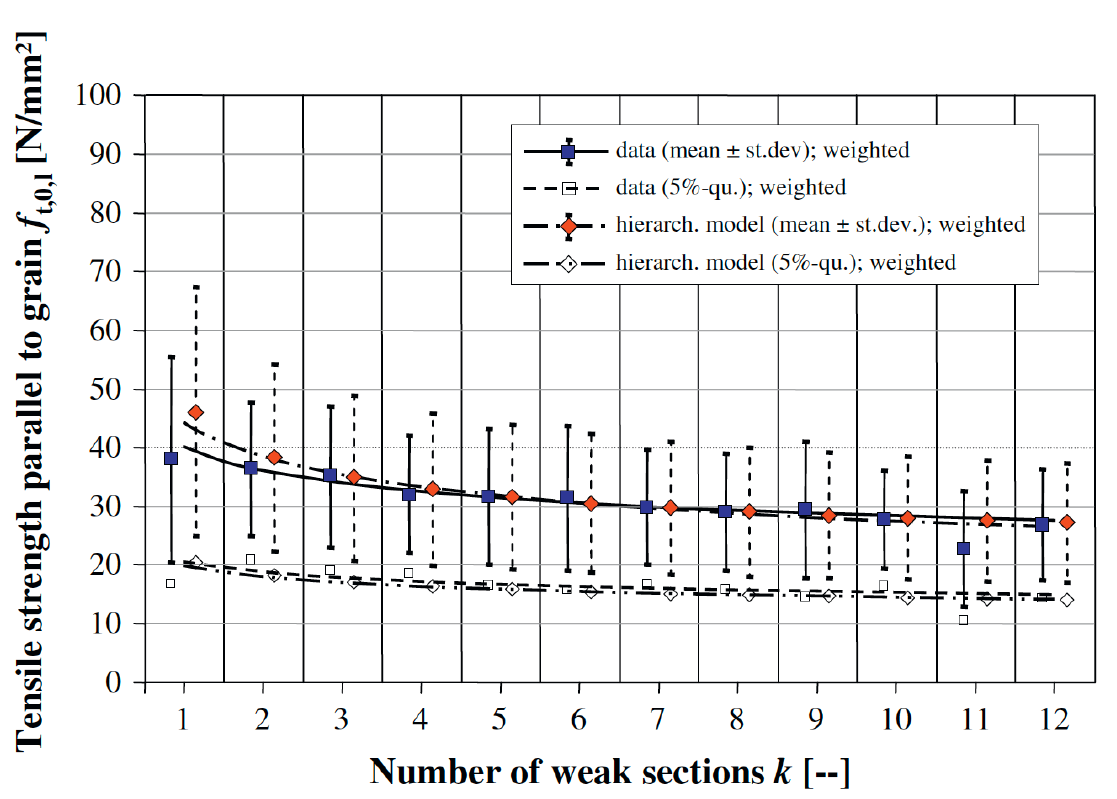
Figure 18. Plot of the tensile strength of a wooden beam against the number of weak sections that it contains. From [101].